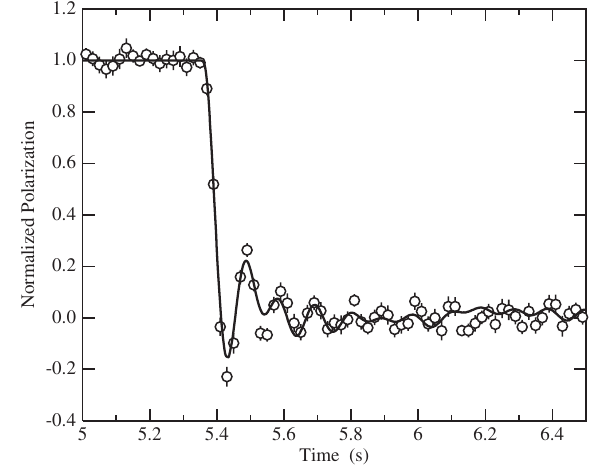
FIG. 16. Measurements similar to Fig. 12 but with a solenoid strength of 2 : 66 (cid:2) 10 (cid:1) 5 rev = turn . The model calculation uses the distribution of 1000 randomly chosen amplitudes.